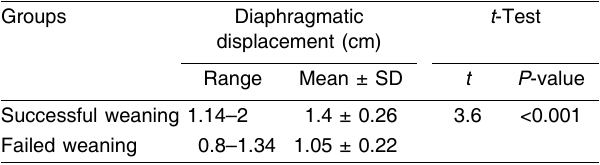
Table 6 Comparison between groups with successful weaning and those with failed weaning as regards diaphragmatic displacement Groups